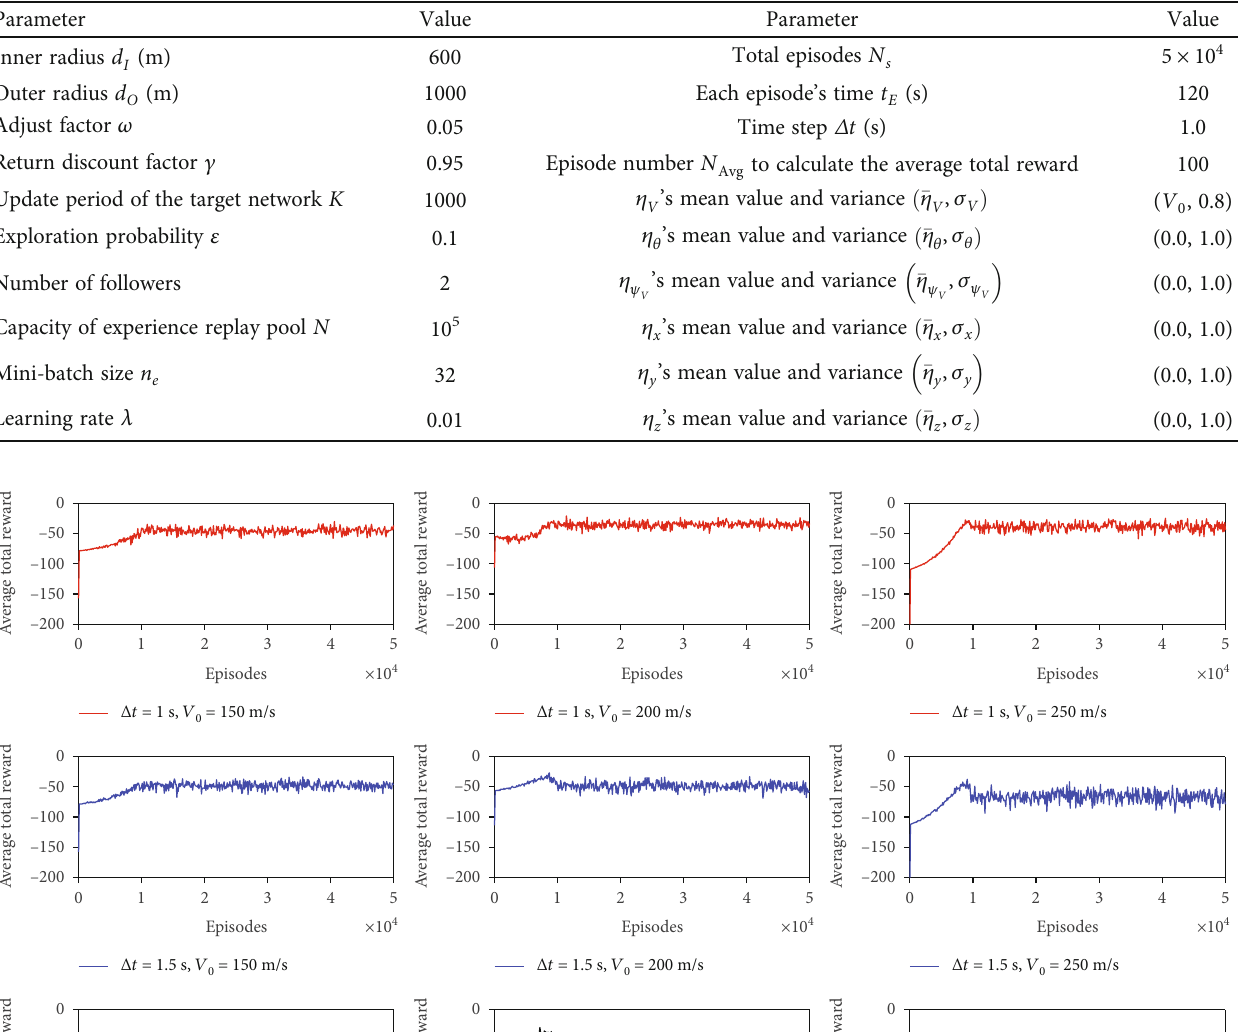
Table 2: Parameter set for the DQN.